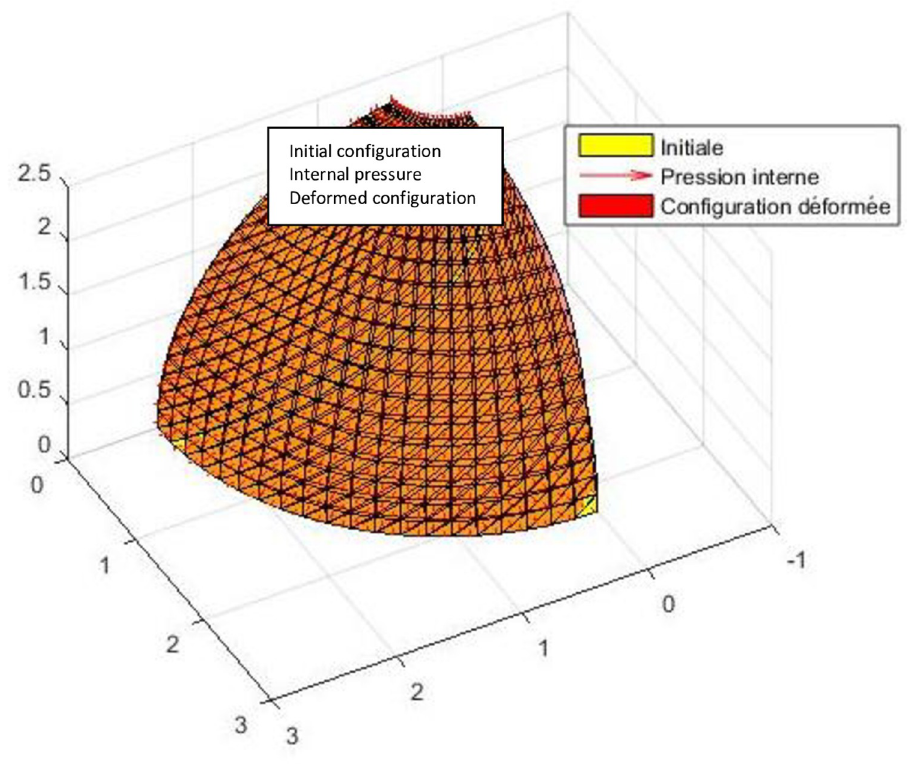
Fig 15. Isometric view of the deformed configuration of ¼ of the sphere (mesh 16 ×